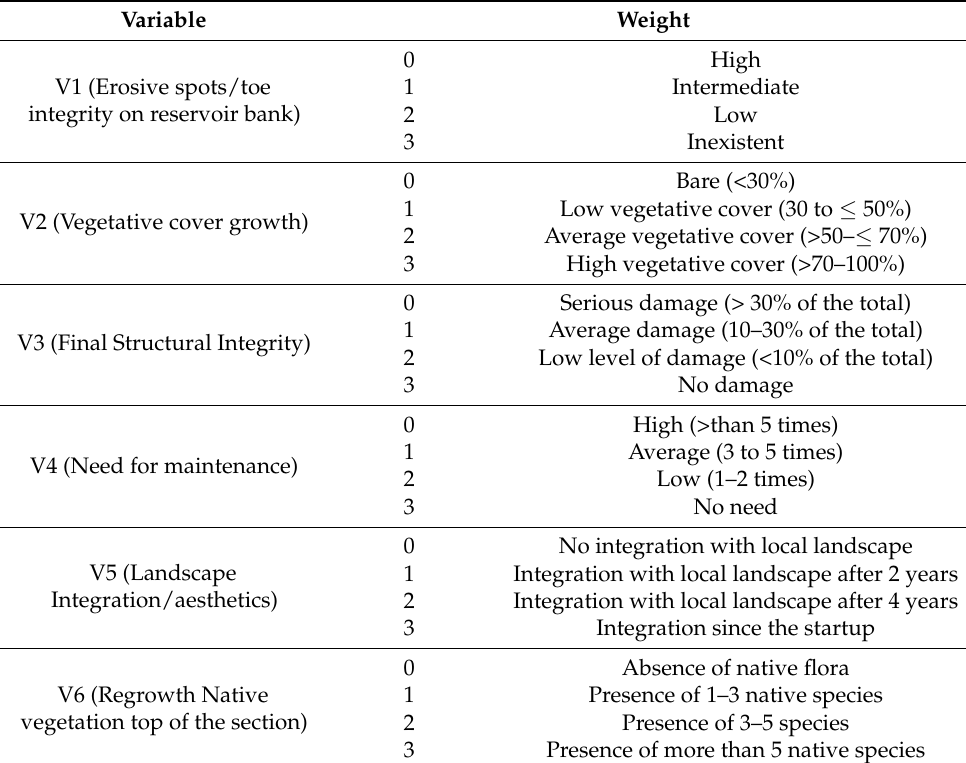
Table 4. Performance matrix of the